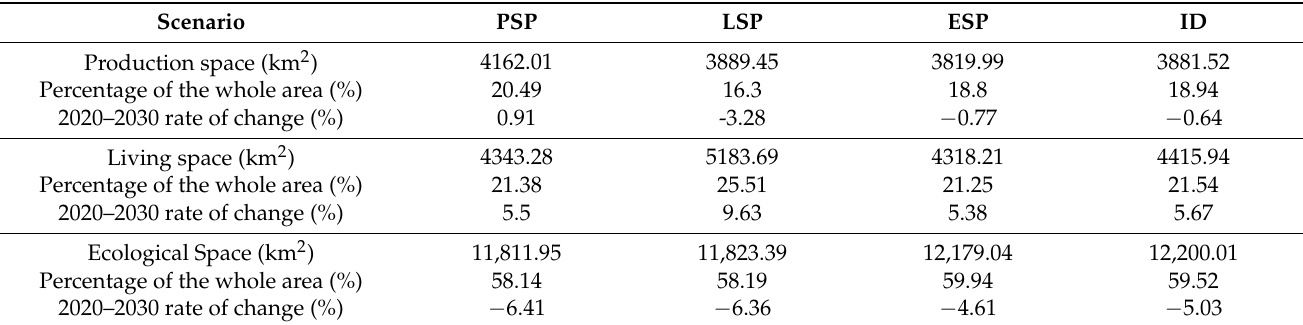
Figure 9. PSP, LSP, ESP, and ID scenario simulation results. Table 6. Area of each space and its percentage in 2030 under the PSP, LSP, ESP, and ID